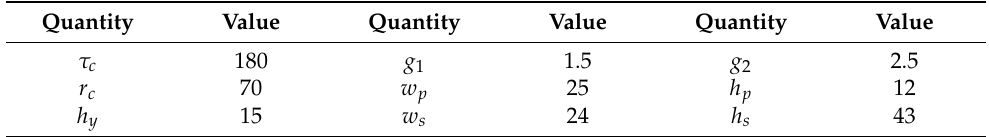
Table 3. Sizes in mm of the basic